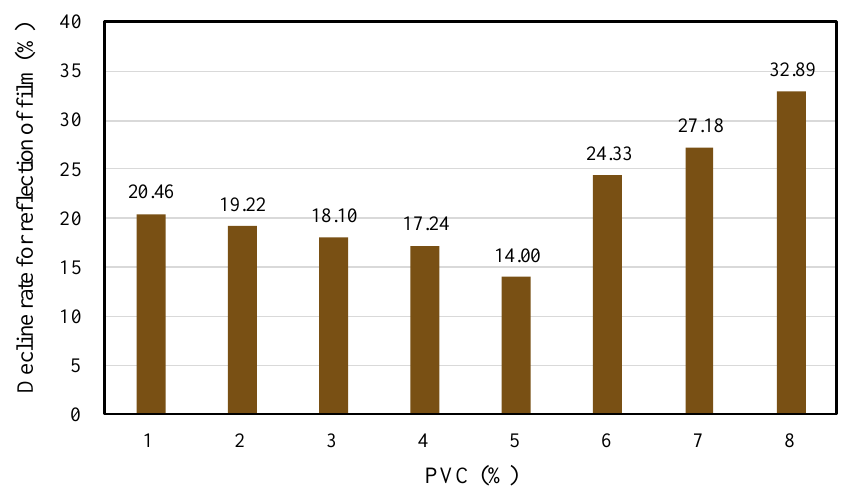
Figure 6. Effect of PVC on water absorption of paint’s film.